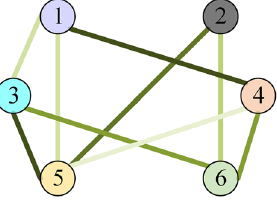
Fig. 5 Graph structure of an adjacency matrix with attention as nodes. Then it is sent to the graph structure module, as shown in Graph structure in Fig.